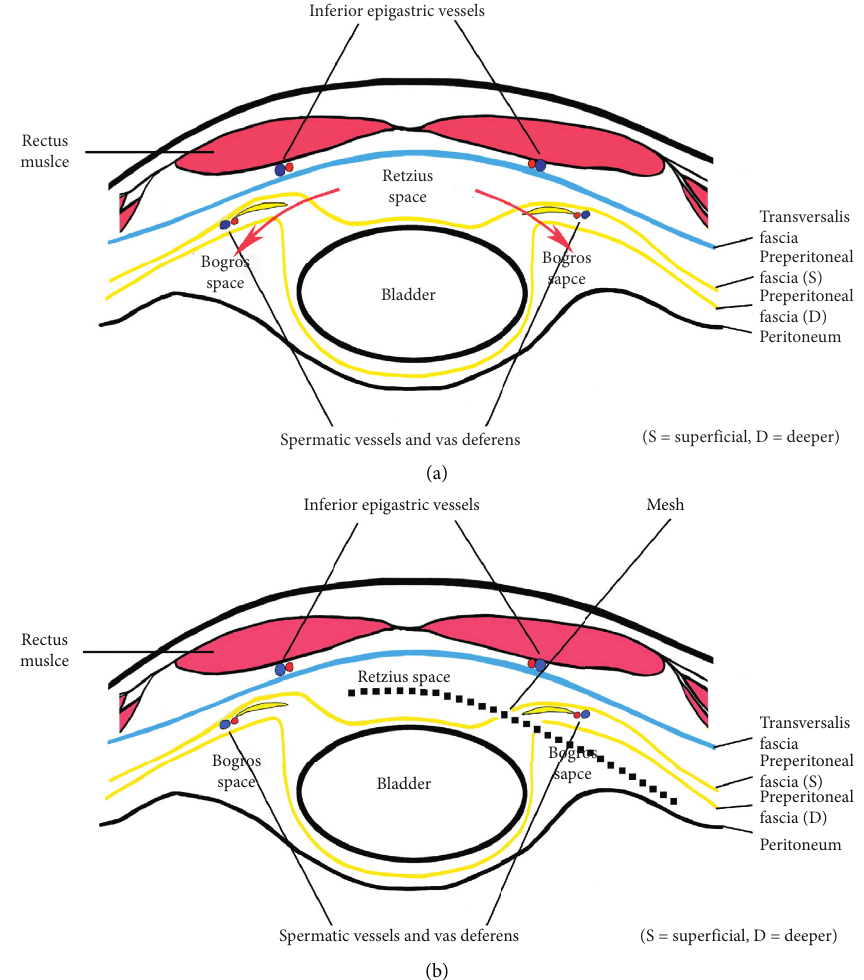
Figure 3: Schematic illustration of a horizontal section of the lower abdominal wall (Retzius’ and Bogros’ space). (a) The red arrows illustrated the approach path into the Bogros space, which communicated these two discontinuity planes for spreading the position of mesh. (b) The position of mesh (dashed line), i.e., placing between the transversalis fascia and the superficial layer of preperitoneal fascia in the Retzius’ space, the deeper layer of preperitoneal fascia, and the peritoneum in the Bogros’